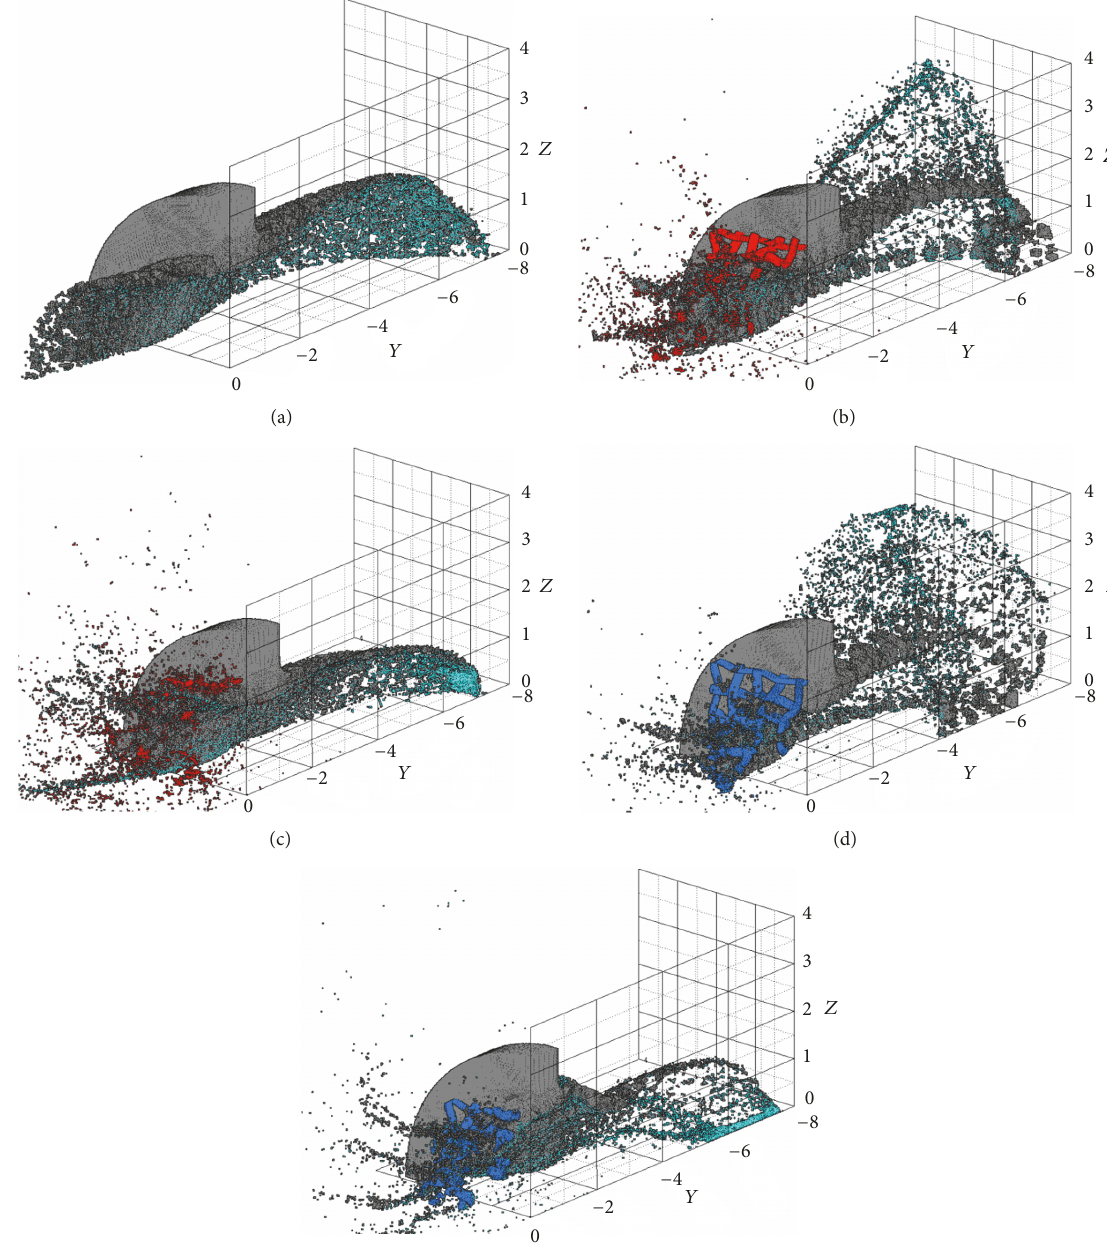
Figure 12: Shapes of the fragment clouds: an isometric